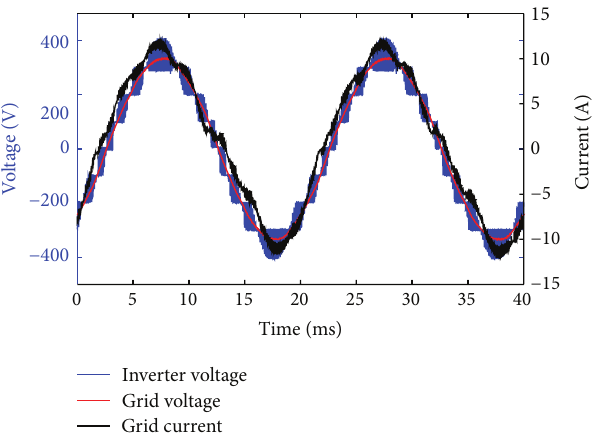
Figure 13: Grid connection of a single-phase 9-level inverter.